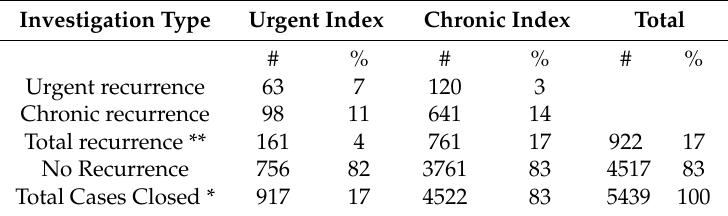
Table 2. 12-Month service recurrence of child protection concerns after closed ongoing protection services (SPI-5) by urgent or chronic classification for 2013/14 (6 agencies) (As reported by Fallon and colleagues